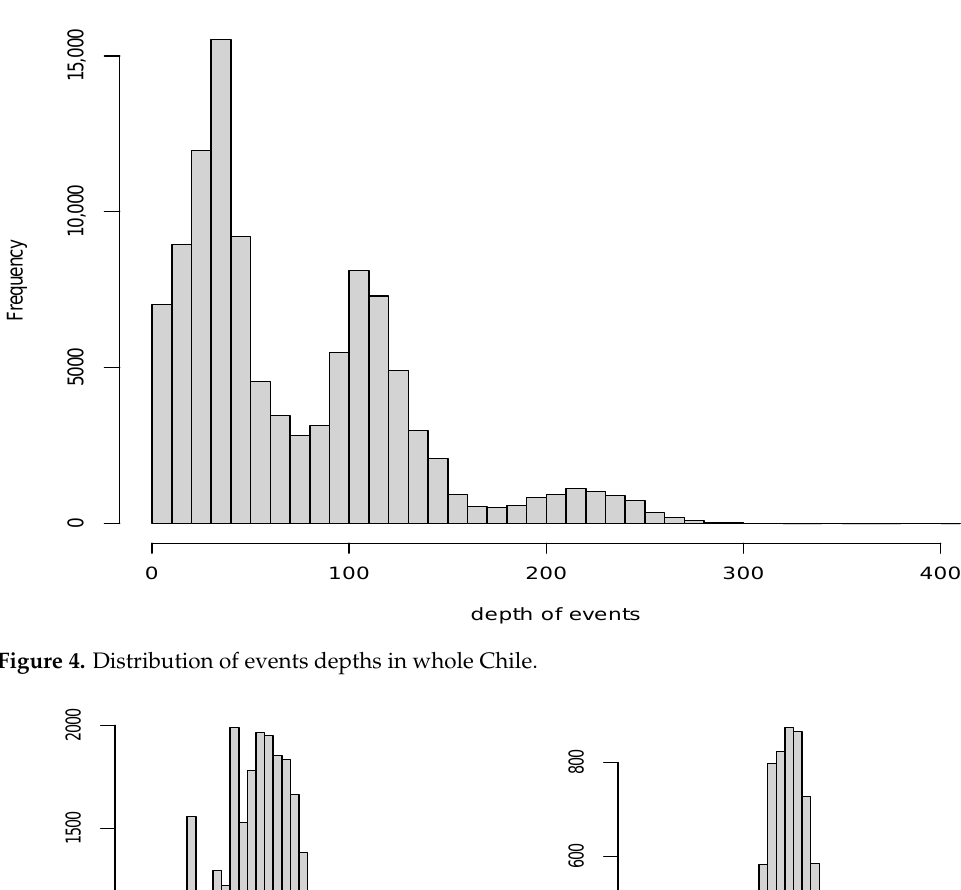
Figure 4. Distribution of events depths in whole Chile.